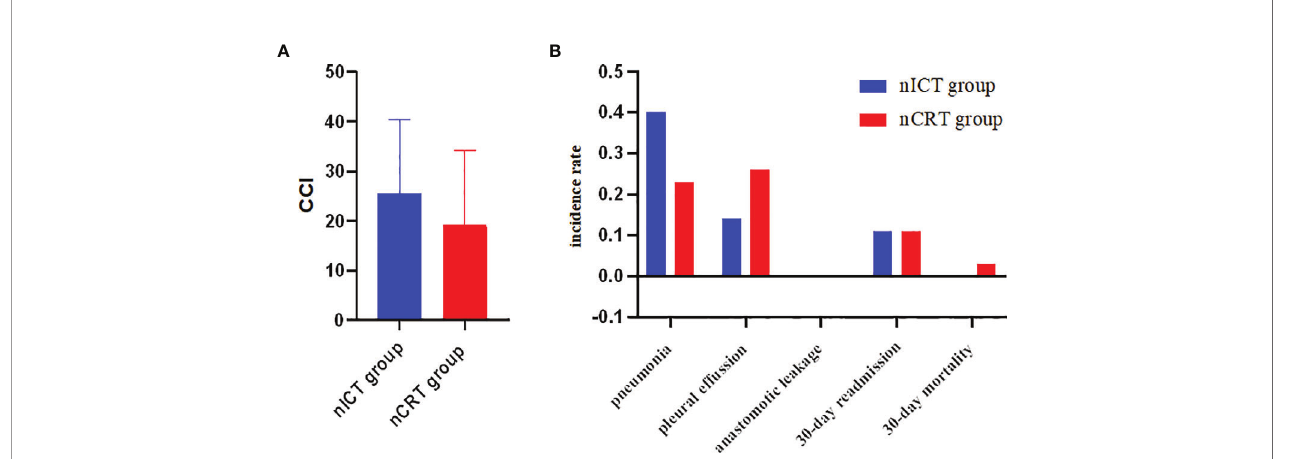
FIGURE 2 | (A) Comparisons of CCI between nICT group and nCRT group after PSM. (B) Comparisons of major complications between nICT group and nCRT group after PSM. CCI, comprehensive complication index; nICT, neoadjuvant chemotherapy and immunotherapy; nCRT, neoadjuvant chemoradiotherapy; PSM, propensity score